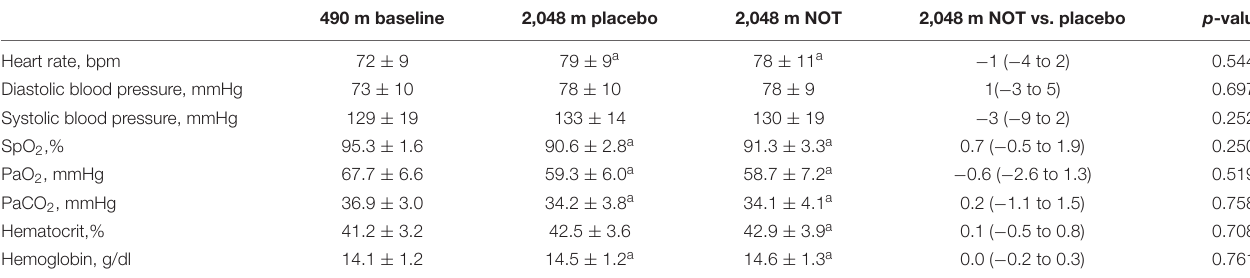
TABLE 2 | Vital signs and blood gases.